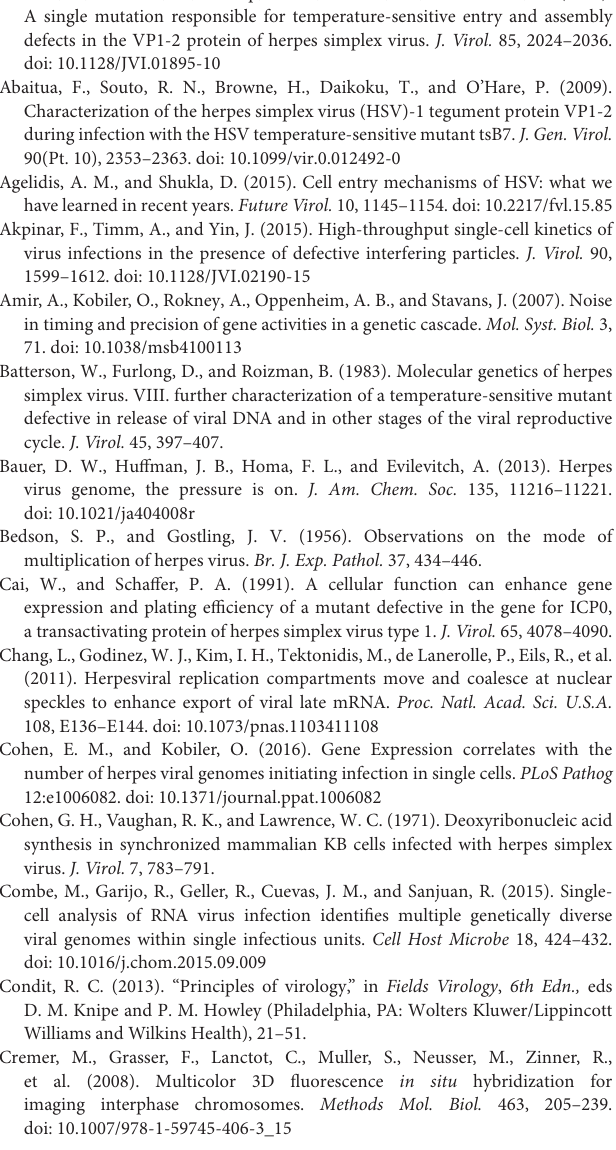
and monitored for fluorescence levels every 10min. The cells were divided into 10 groups according to the onset time. For each group the average onset time and average fluorescence level at 6 hpi were calculated and plotted. A trend line, calculated using the ordinary least squares (OLS) method and the measured Pearson correlation, is presented in the graph. Error bars represent the standard error of the mean for each group. Supplementary Movie 1 | Cells infected with OK11 at MOI 5 were monitored for 12h at 37 ◦ C. Scale bar 20 µ M. Images were taken every 10min and played at